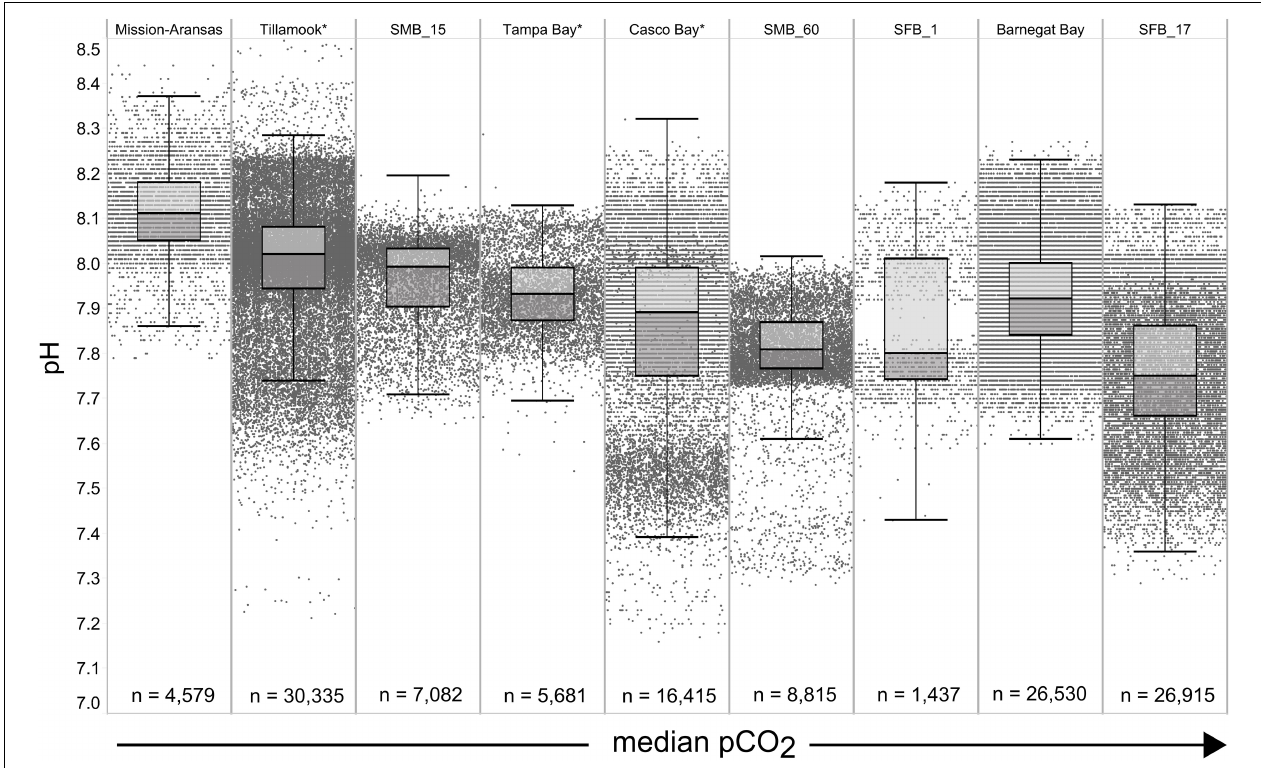
FIGURE 5 | Box plots and underlying data showing the distribution of pH data across the seven water bodies. The water bodies are arranged from lowest median partial pressure of carbon dioxide ( p CO 2 ) (Mission-Aransas Estuary) to highest median p CO 2 (Barnegat Bay) as calculated from all available data. Whiskers extend to data within 1.5 times the interquartile range; * = multi-year records. SMB. SMB_15 = Santa Monica Bay (15 m deployment); SMB_60 = Santa Monica Bay (60 m deployment); SFB_1 = San Francisco Bay (1 m deployment); SFB_17 = San Francisco Bay (17 m